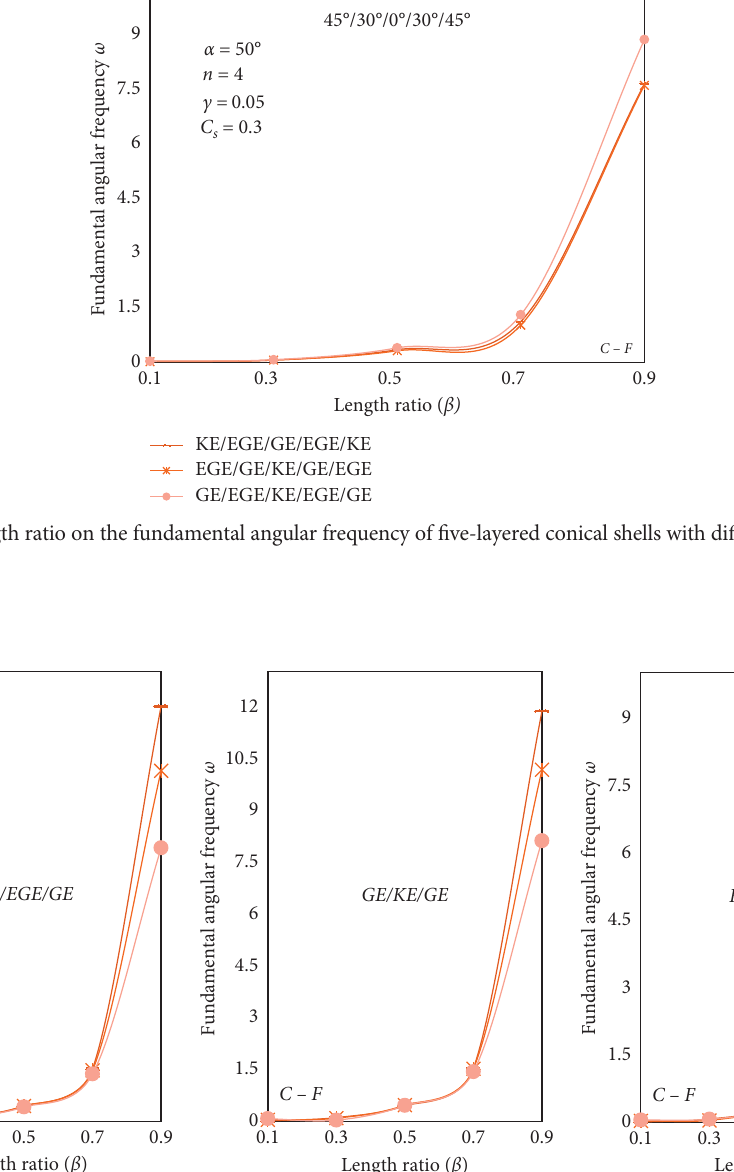
Figure 14: Influence of length ratio on the fundamental angular frequency of three-layered conical shells with different material orientation of 30 ° /60 ° /0 ° /60 ° /30 ° . Normalization is done with Figures 18(a)–18(c) exhibit the mode shapes for dis- placement function W of symmetric angle-ply conical shells of respect to the maximum transverse displacement W . As ex- material combinations EGE / GE / KE / GE / EGE and ply pected, the transverse displacements are mostly predominant.